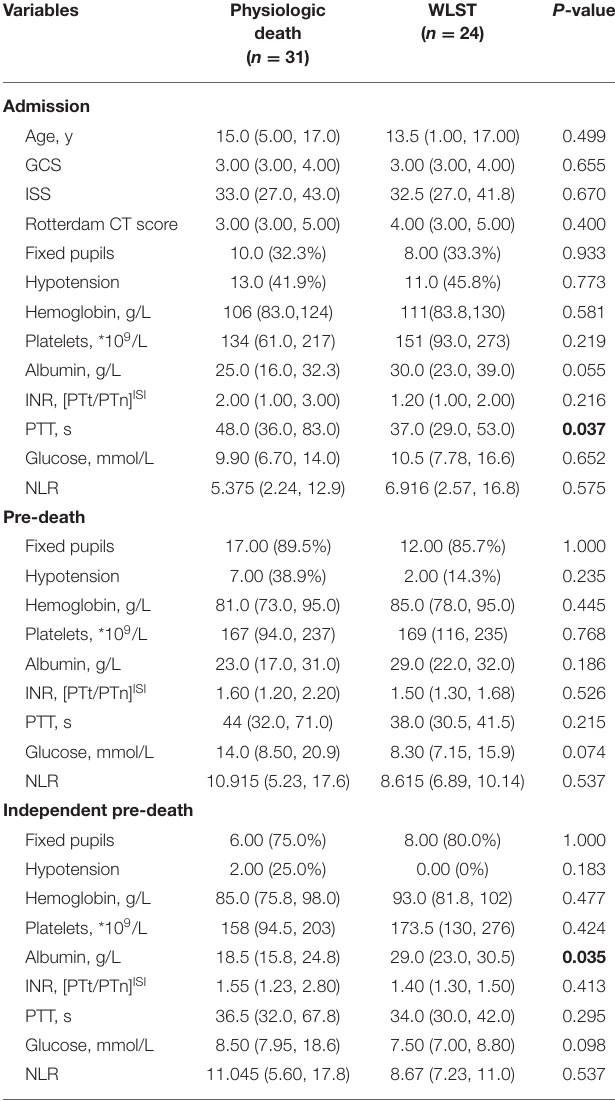
TABLE 3 | Clinical and laboratory findings on admission and prior to death by mode of death.